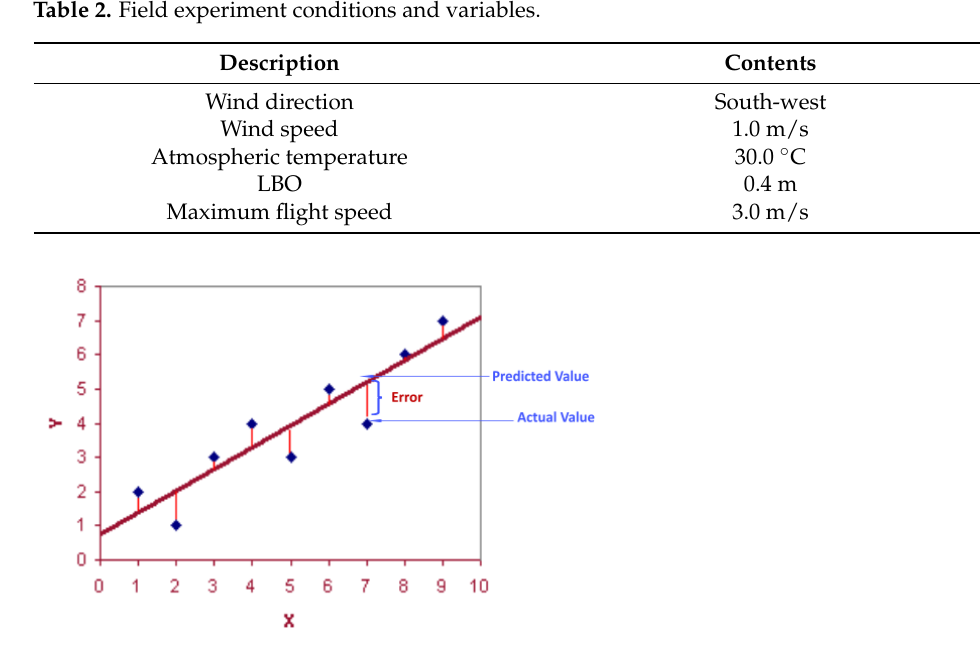
Figure 11. Flight accuracy measurement.